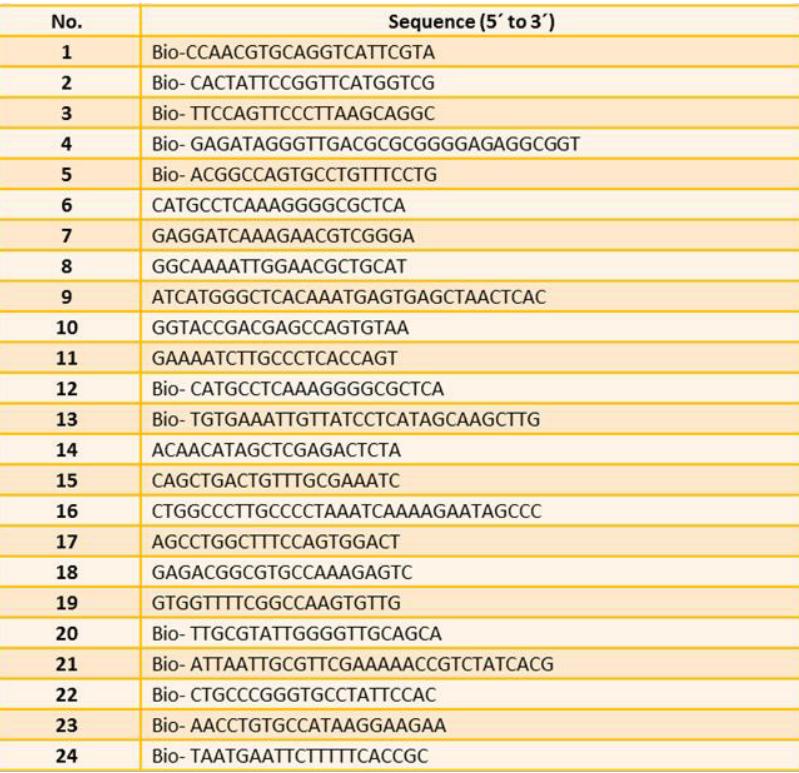
Table 1. Staple oligonucleotide sequences for self-assembly of